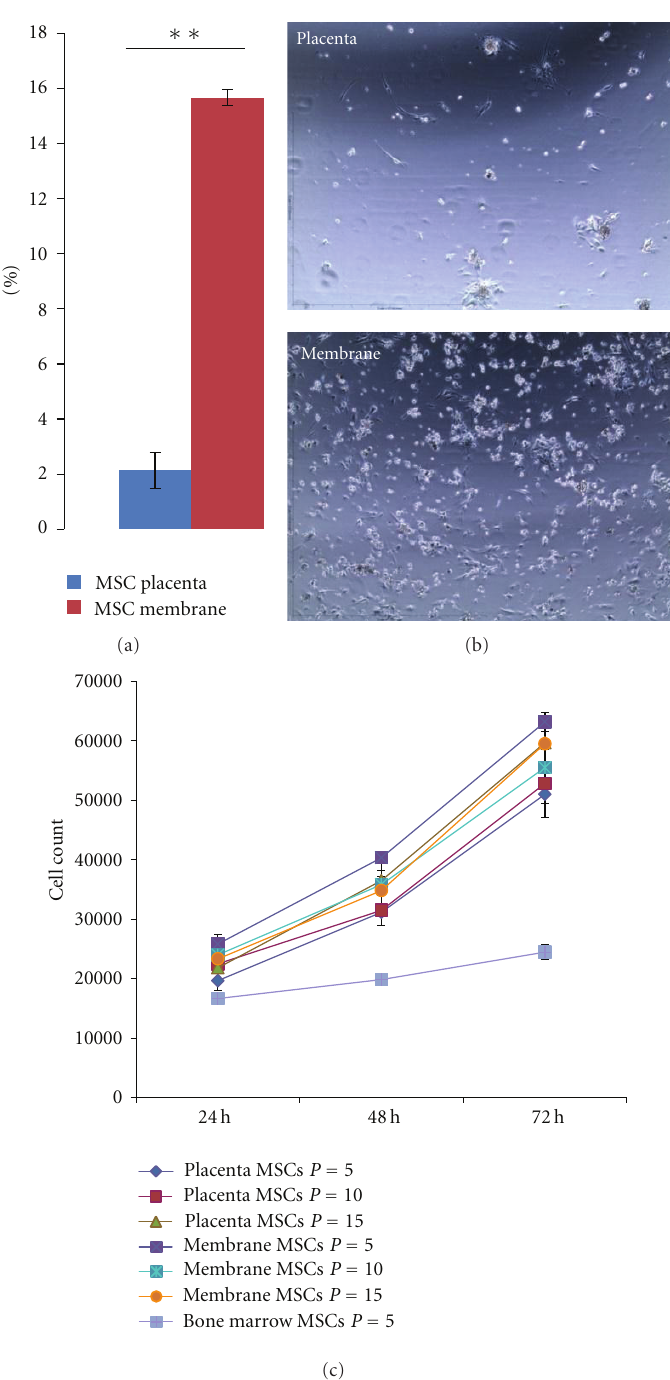
Figure 1: Higher proportion of MSCs can be isolated from the membrane compare to the placenta. Fetal tissue derived MSCs display greater proliferation kinetic than bone marrow derived MSCs. (a) MSCs were defined as CD45 − , CD34 − , CD29 + , CD90 + , CD73 + , and CD105 + . Their proportion was then calculated in freshly digested placenta specimens and fetal membranes form 3 di ff erent donors. MSCs represented 15.67% ( ± 0.29%) and 2.14% ( ± 0.65%) of cells isolated from the membrane and placenta, respectively ( ∗∗ P = 9 . 25 · 10 − 4 ). (b) Day 1 phase contrast microscopy of adherent cells from placenta and membrane directly plated after tissue digestion in MSCs media. We can see significantly more adherent cells from digested membrane compared to placenta. (c) MSCs derived from placenta and membranes were expanded up to passage 15 without changes of their morphology or proliferation rate. Proliferation rate was assessed by cell counting at di ff erent passages. It was similar in placenta- and membrane-derived MSCs with no di ff erences between early and late passages. However, proliferation rate was significantly higher than proliferation rate of bone-marrow-derived